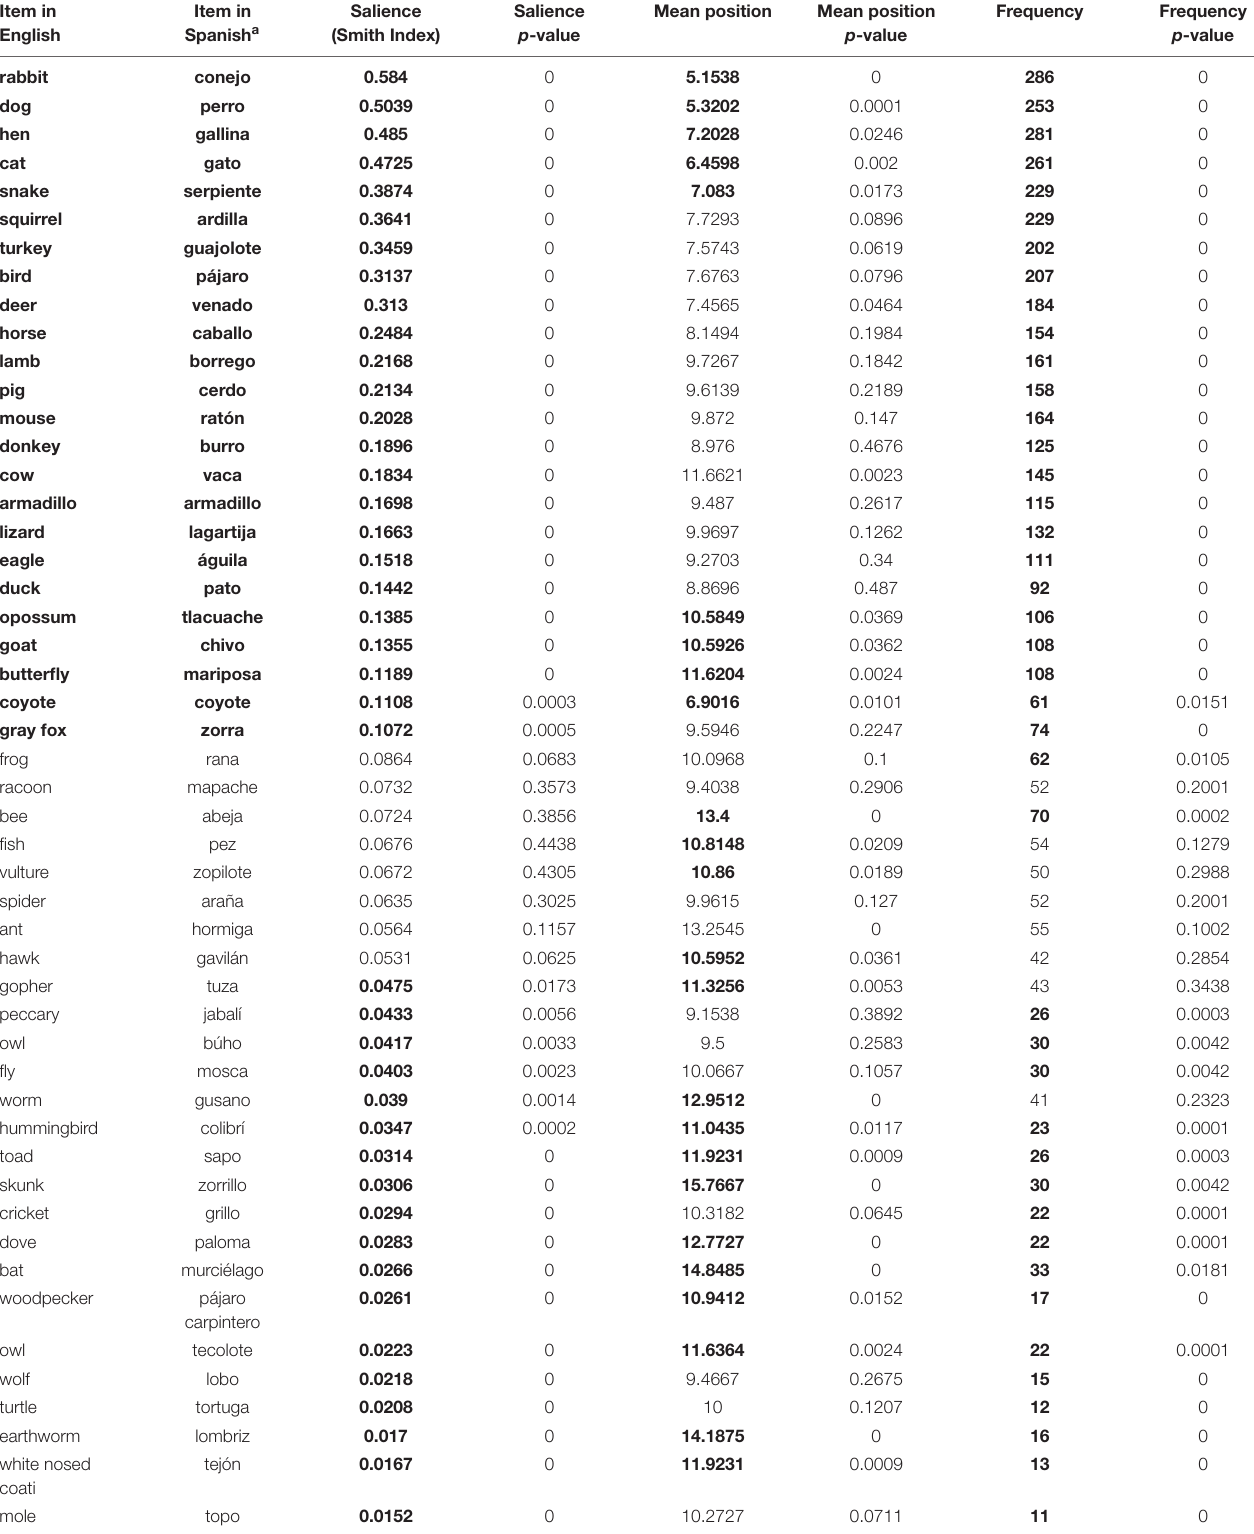
TABLE 2 | Smith salience index, mean position, and frequency of wild and domestic animal items in 356 students’ free lists, with p -values. Item in